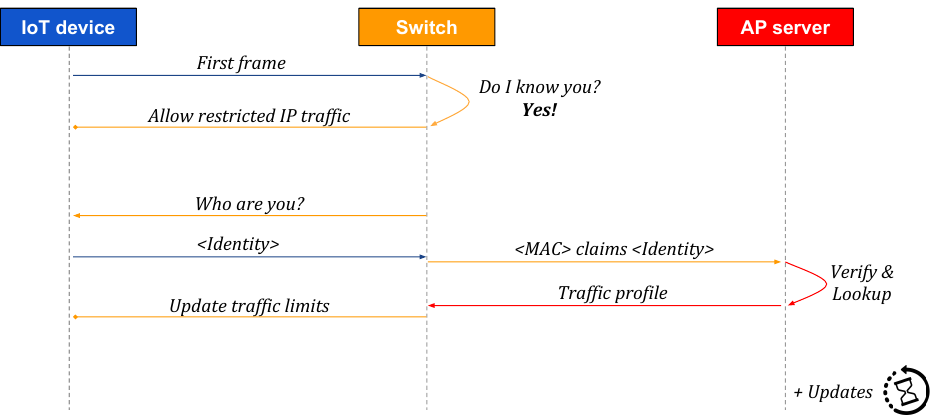
Figure 4. Sequence of messages: the switch has all required information on the connecting IoT device in its local cache of the already seen devices, and thus can immediately admit the device to the network. The standard procedure continues asynchronously, in order to fetch possible updates to the traffic